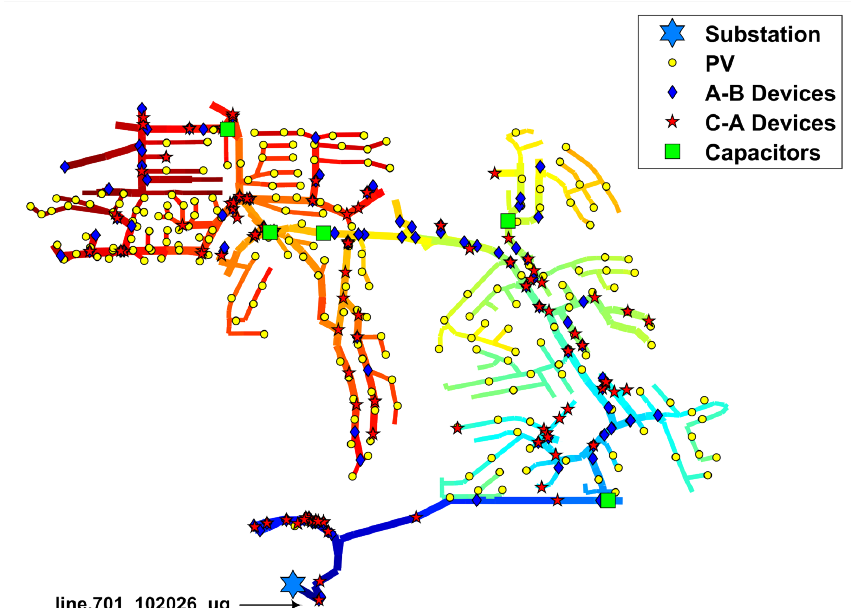
Figure 19. One-line diagram of the distribution circuit shows the locations of the PVs (PVs), line-to-line power electronic interfaces connected across A-B phase (A-B devices) and C-A phase (C-A devices), and capacitor banks.